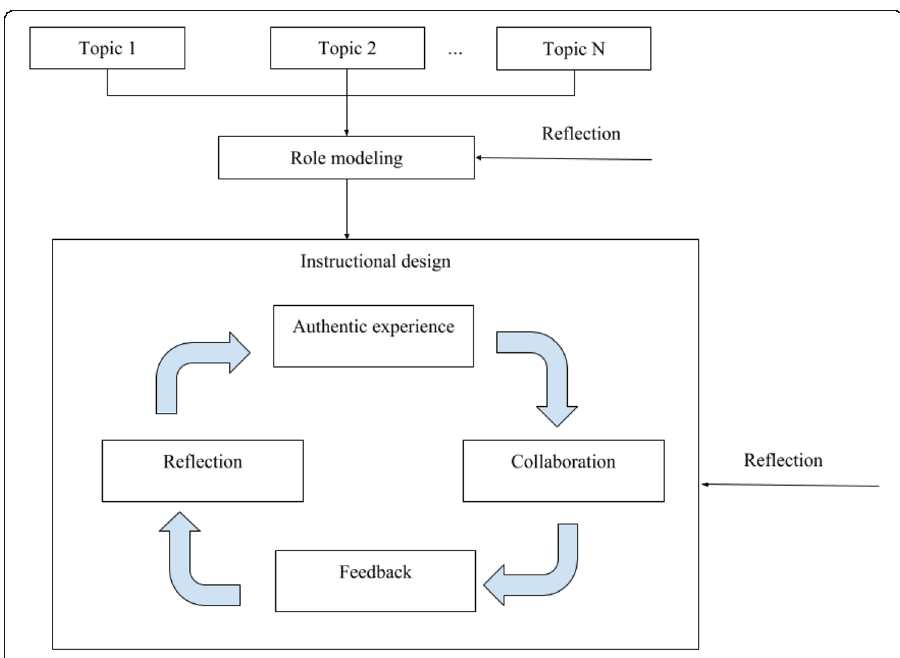
Fig. 1 Design of the proposed ICT